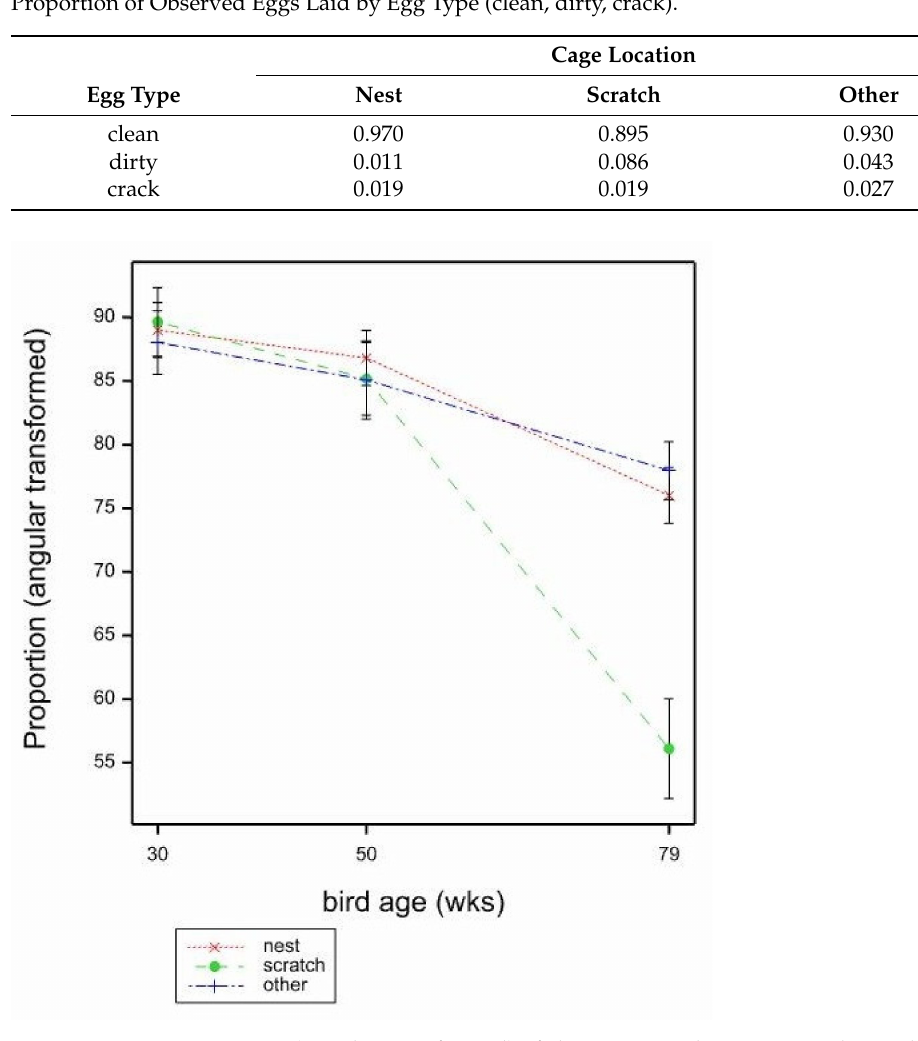
Figure 6. Mean proportions (angular transformed) of clean eggs per location according to bird age (30, 50, 79 weeks) and cage location (nest, scratch mat, other areas of the cage) estimated from LMM. Mean SE